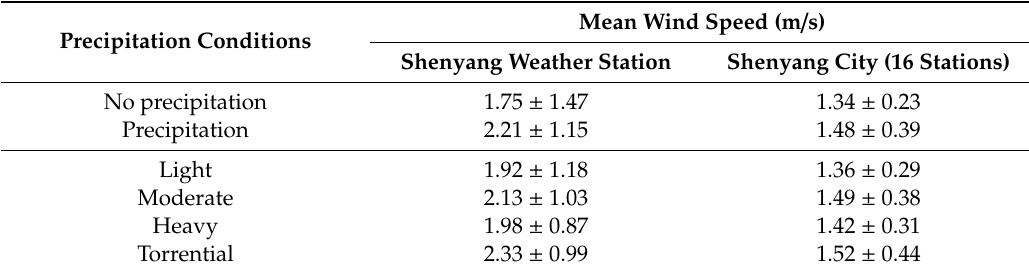
Table 5. Mean wind speed at Shenyang weather station and the 16 stations with standard deviations under di ff erent precipitation conditions